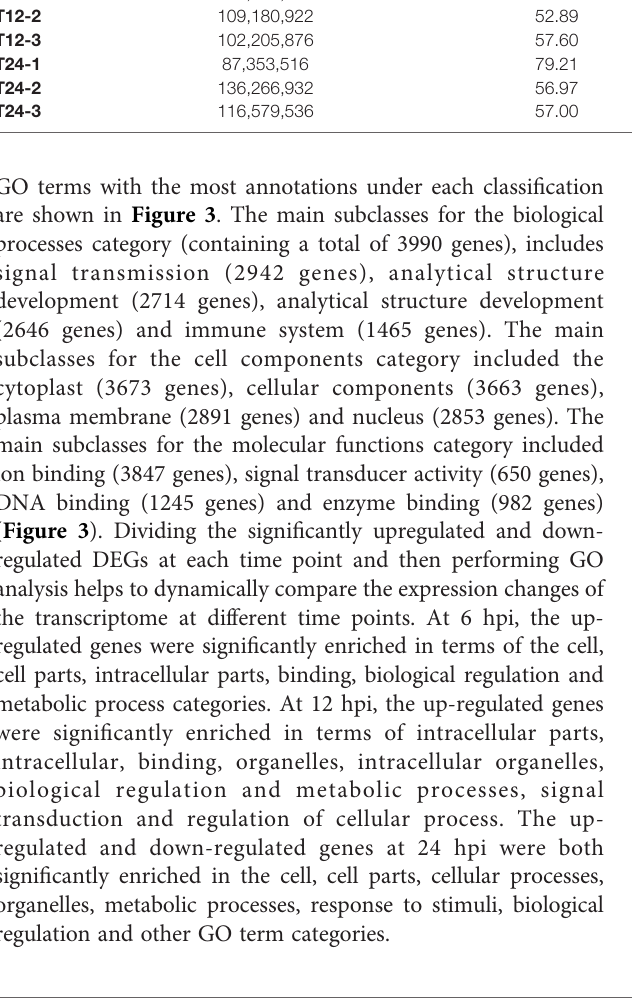
TABLE 4 | Statistical results for mapping the trimmed reads with the Y. ruckeri reference genome. Sample